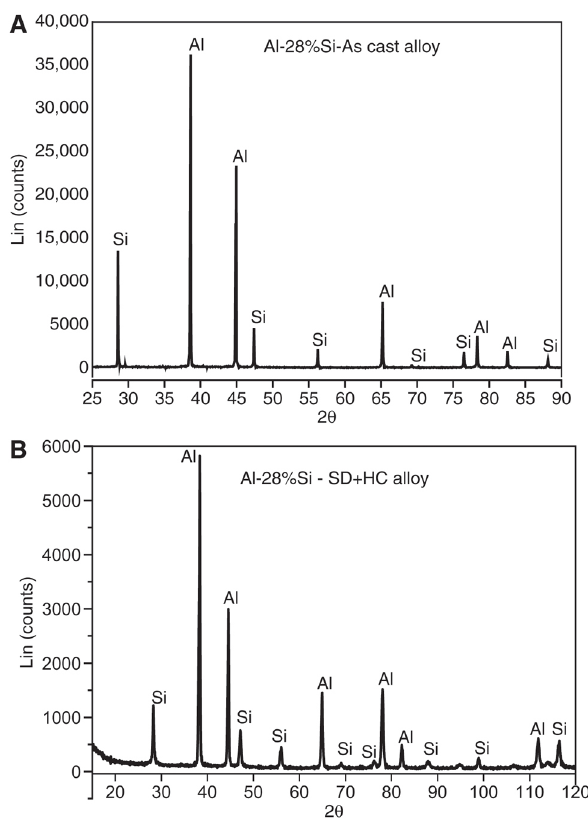
Figure 1: XRD analysis of the Al-28Si alloy (A) as-cast alloy and (B) SD+HC alloy.